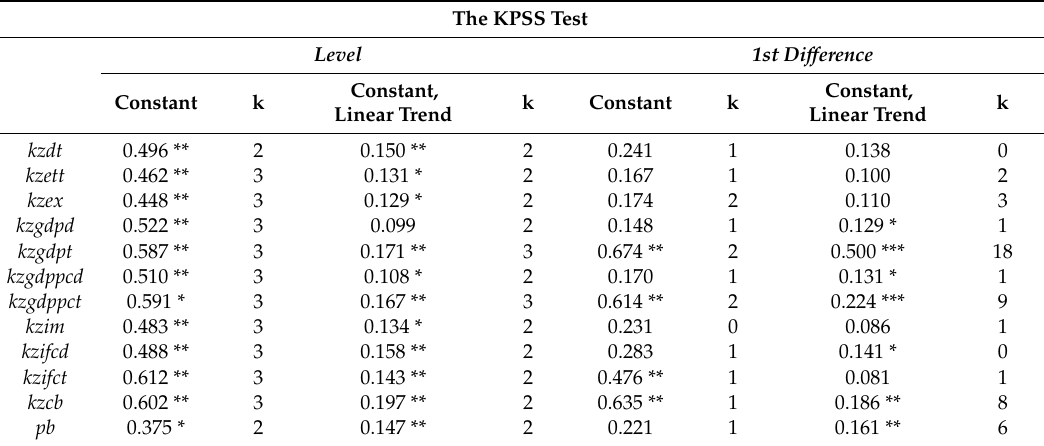
Table A25. KZ. The Unit Root test